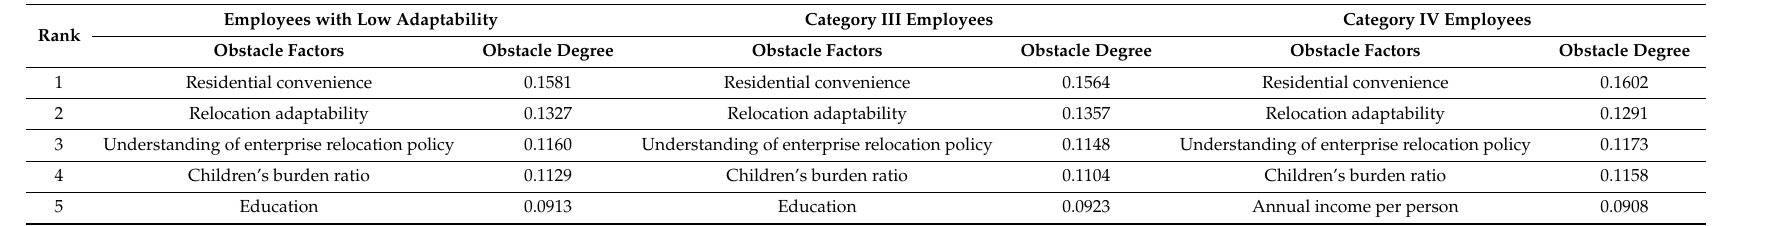
Table 6. The factors and degree of obstacles to employees’ sustainable livelihood ability in relocation